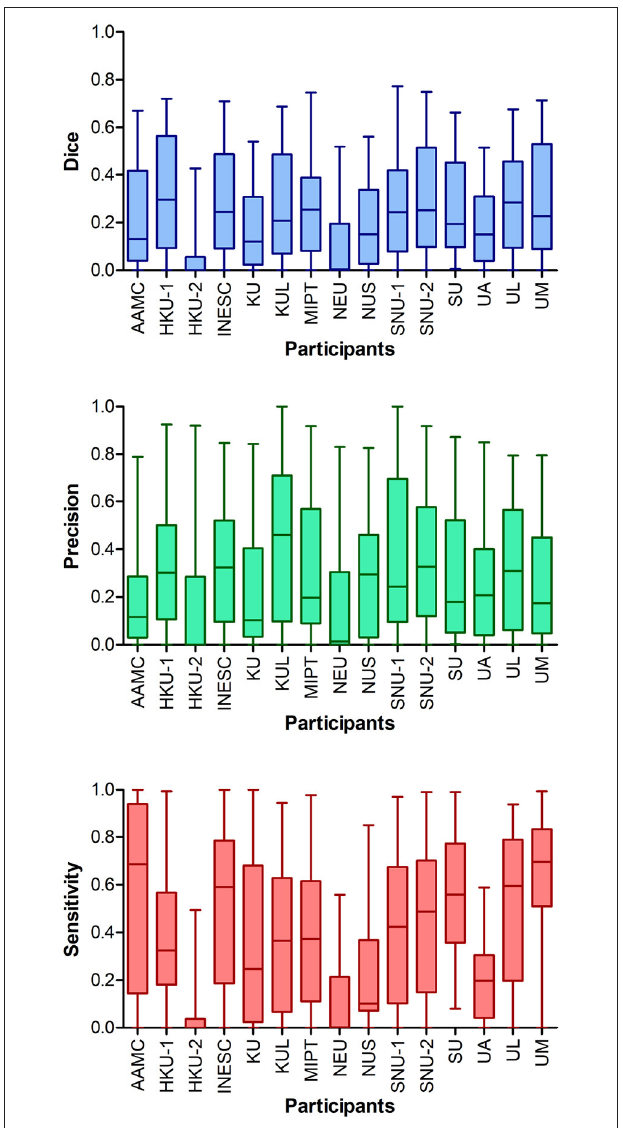
FIGURE 4 | Performance metrics for all teams of ISLES 2017. Higher ranking teams (e.g., 1st place SNU-2) achieved Dice scores > 0.7 for some cases, however, overall Dice scores clustered around 0.2–0.3. The two teams ranked last (NEU and HKU-2) showed much lower Dice scores than all other teams, which was a consequence of the low number of successful submissions. The model of UM seemed to be most sensitive to detect lesions, but lacks in